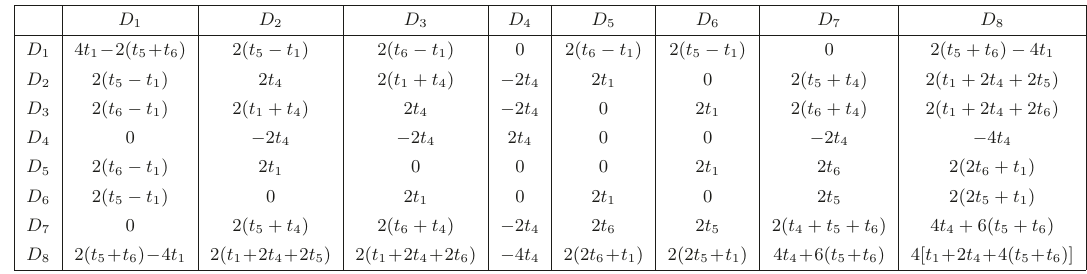
Table 4 . Intersection curves of two coordinate divisors. Here numbers h 0 , 0 = 1 and h 1 , 0 = g .